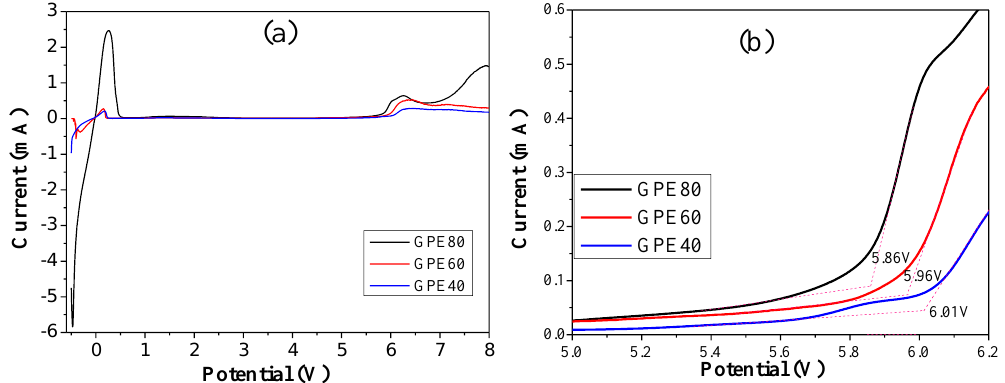
Figure 4. ( a ) Electrochemical window test results of GPE; ( b ) Enlargement of ( a ) at 5.0–6.2 V.